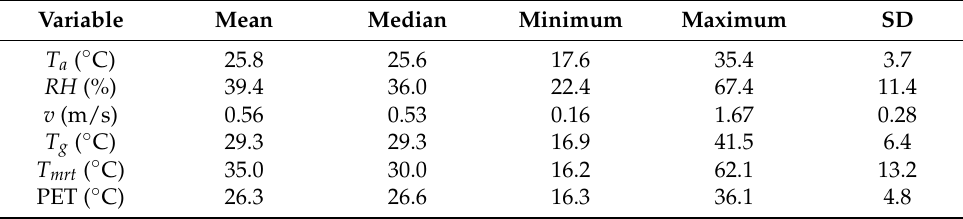
Table 2. Meteorological variables and thermal index in field studies.